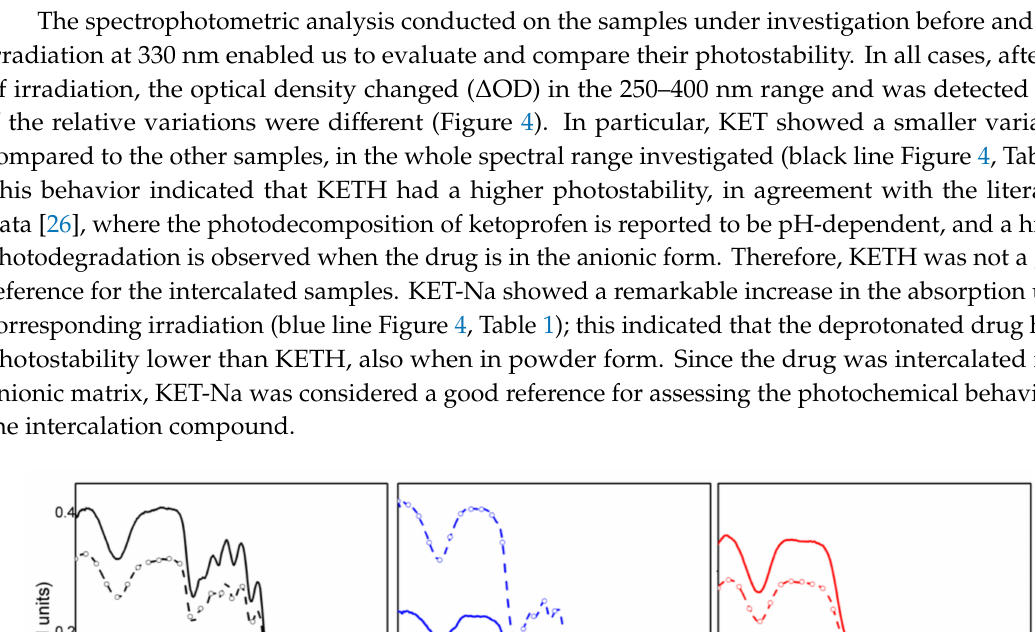
Figure 3. Absorption spectra of crystalline KET in acid form (KETH) (black line), KET-Na (blue line), and ZnAl-KET (red line).